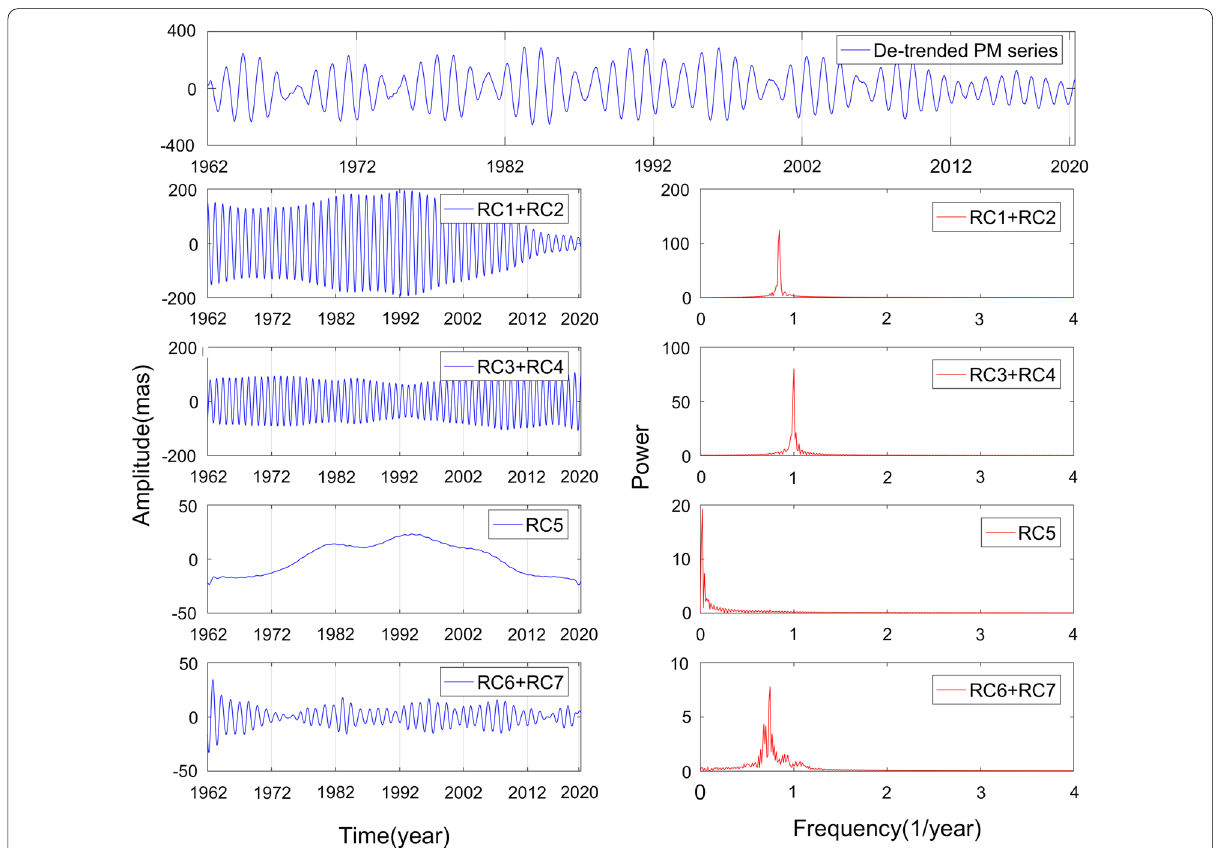
Fig. 4 RCs in the Y-direction of PM and its perform power spectrum